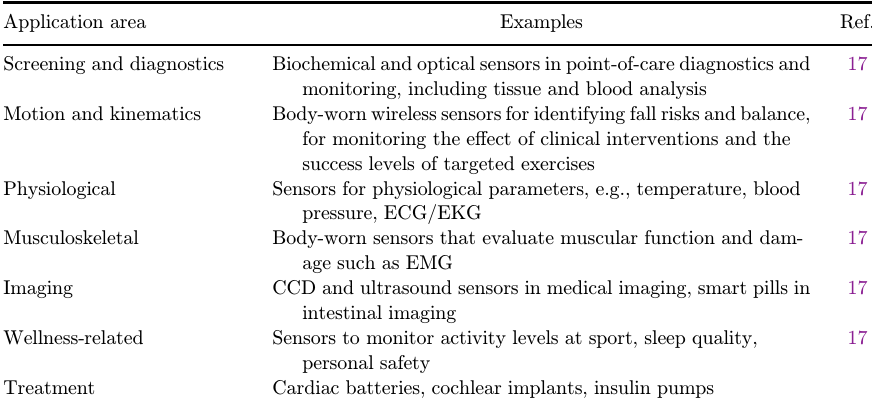
Table 2. Main application areas of sensors in clinical healthcare. Application